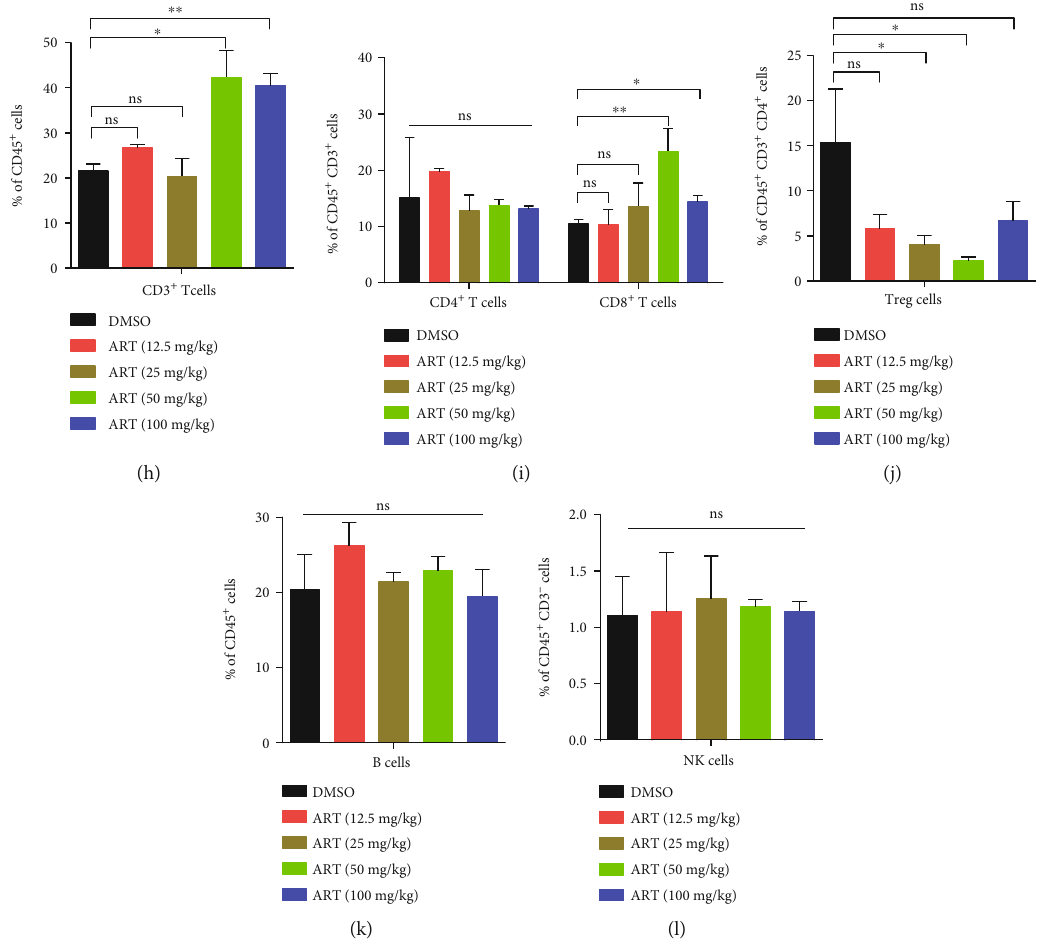
Figure 4: Targeting MDSCs by ART reduces tumor growth in two mouse tumor models. (a – c) C57BL/6 mice injected s.c. on day 0 with B16F10 melanoma cells and received subsequent i.p. injections of either DMSO or di ff erent doses of ART (12.5, 25, 50, and 100mg/kg) once every day starting from day 9 of B16F10 tumor model. (a) Tumor growth curve, (b) mice weight curve, and (c) tumor weight recorded from B16F10 tumor-bearing mice ( n = 5 mice per group). (d) Survival curve of DMSO and ART 50mg/kg-treated B16F10 tumor-bearing mice ( n = 5 mice per group). (e – l) The proportions of immune cells in tumor tissues: MDSCs, M-MDSCs, G-MDSCs, DCs, macrophages, CD3 + T cells, CD4 + T cells, CD8 + T cells, Treg cells, B cells, and NK cells were detected by fl ow cytometry. MDSCs were CD45 + CD11c - F4/80 - CD11b + Gr-1 + cells; M-MDSCs were CD45 + CD11c - F4/80 - CD11b + Ly6G − Ly6C high cells; G-MDSCs were CD45